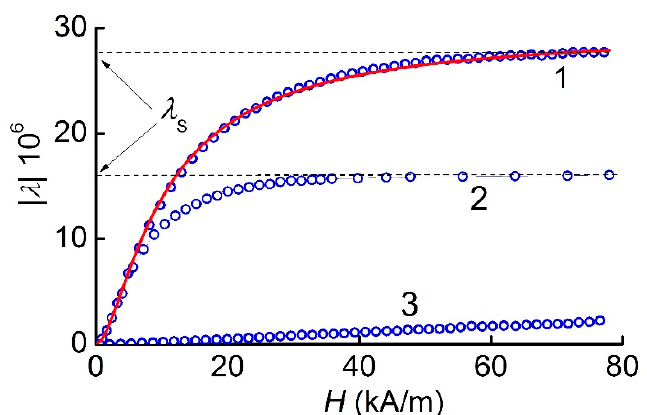
Figure 4. Dependence of magnetostriction λ on the field magnitude H for: 1-MFC with a period T 1 of 250 µ m, magnetized along the wires; 2-MFC with a period T 2 of 500 µ m, magnetized along the wires; and 3-MFC with a period T 1 of 250 µ m, magnetized across the wires. The solid curve is the approximation of magnetostriction ( λ ( H )) by Equation (5).